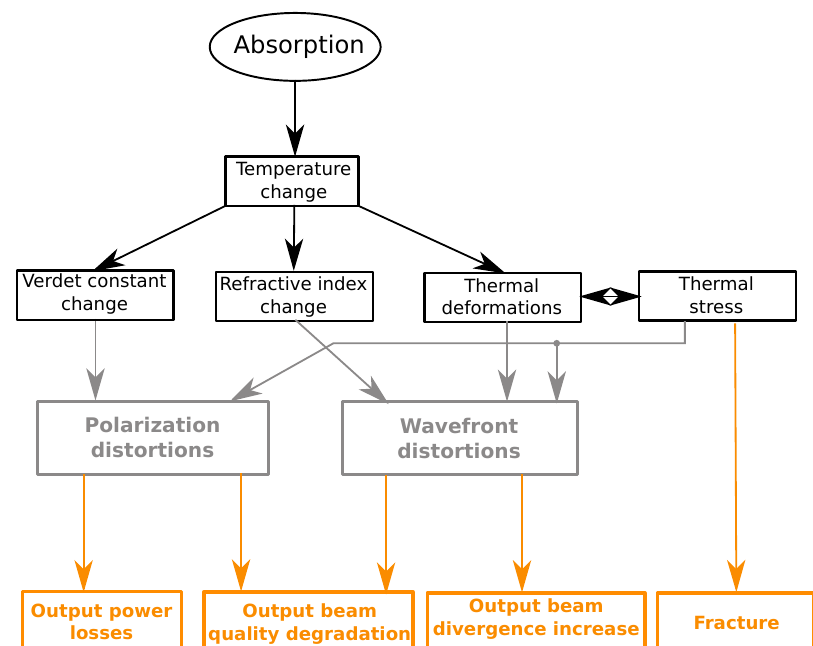
Figure 1. A simplified scheme of the physical phenomena involved in the absorption-induced thermal effects in magneto-active